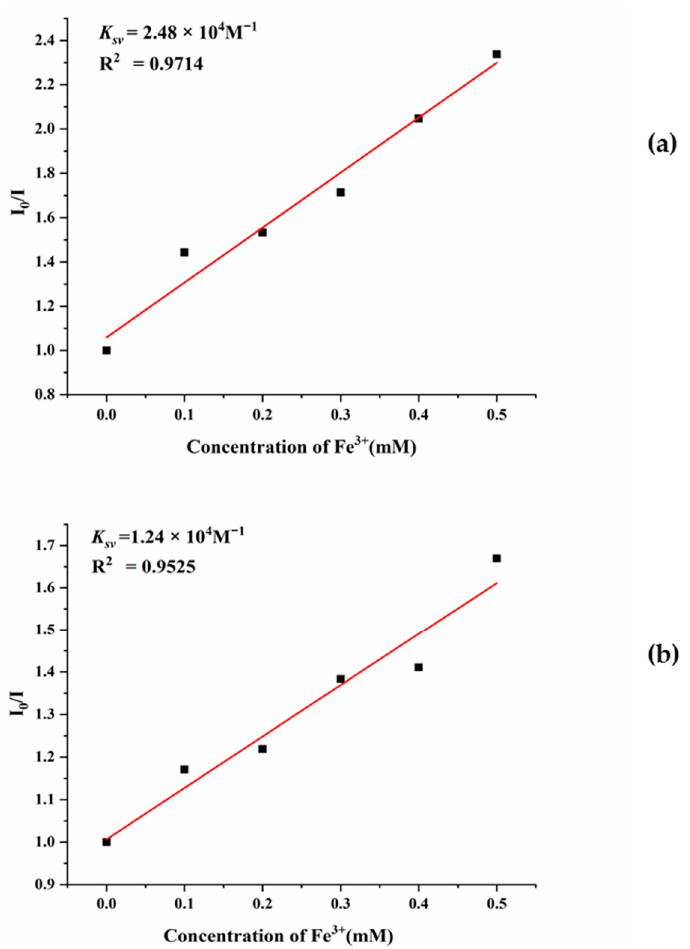
Figure 9. The Stern–Volmer plot of I 0 /I versus Fe 3+ ions’ concentration for ( a ) 7 ( λ ex = 325 nm) and ( b ) 8 ( λ ex = 326 nm).